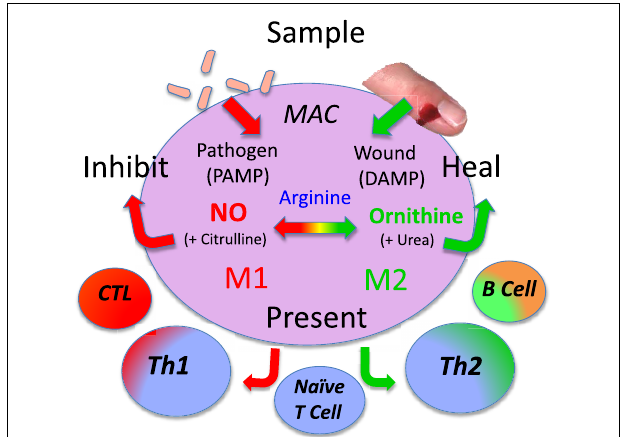
FIGURE 10 | Macrophages have four basic SHIP functions [sample, heal, inhibit and present (antigen)] that allow them to recognize pathogens or injury, and respond directly (or indirectly by presenting antigens) to engender responses that provide optimal host protection . From Ref. (1) with permission from S. Karger AG,